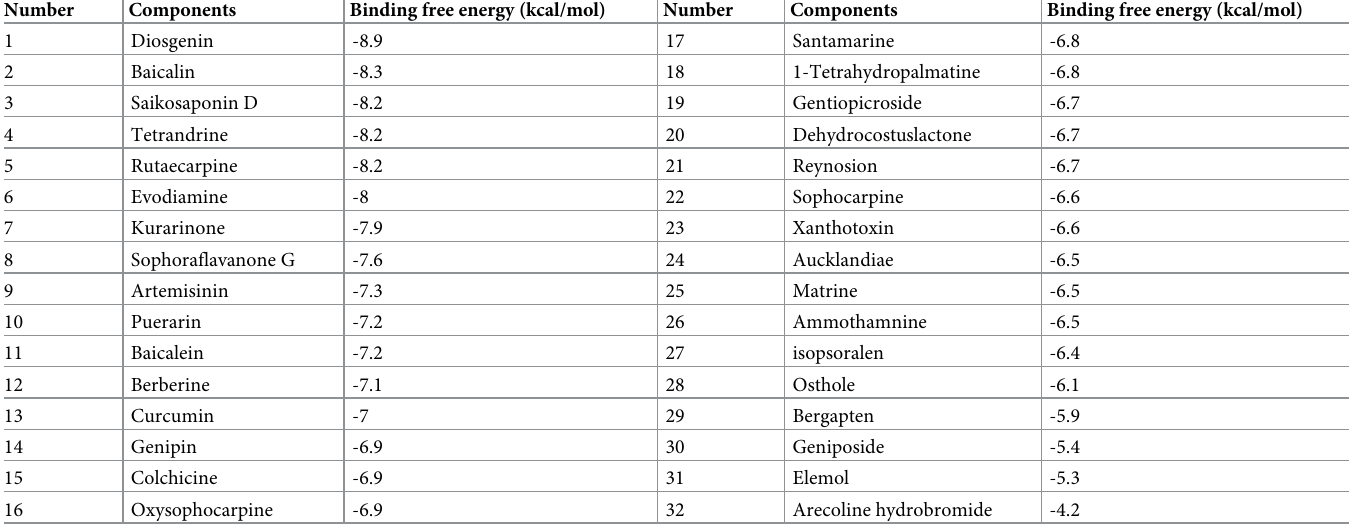
Table. In each of the drug-administered groups, three concentrations before and after the cell viability significantly decreased were subjected to subsequent experiments. The results of the colorimetric assay for investigating ALT, AST, LDH, and ALP activities among different components groups, revealed that the levels of ALT, AST, LDH and ALP Table 4. Binding free energy for 32 components with potential liver